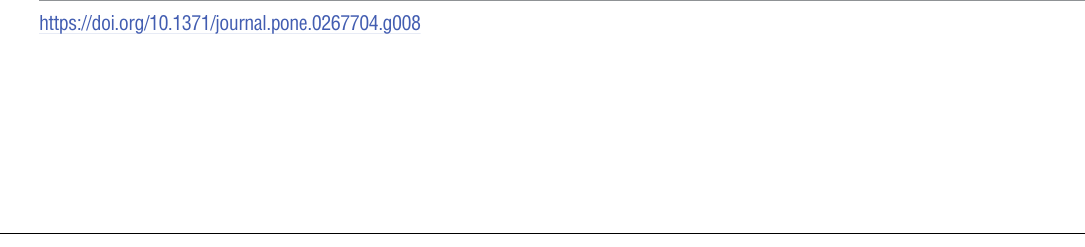
PLOS ONE | https://doi.org/10.1371/journal.pone.0267704 June 3,